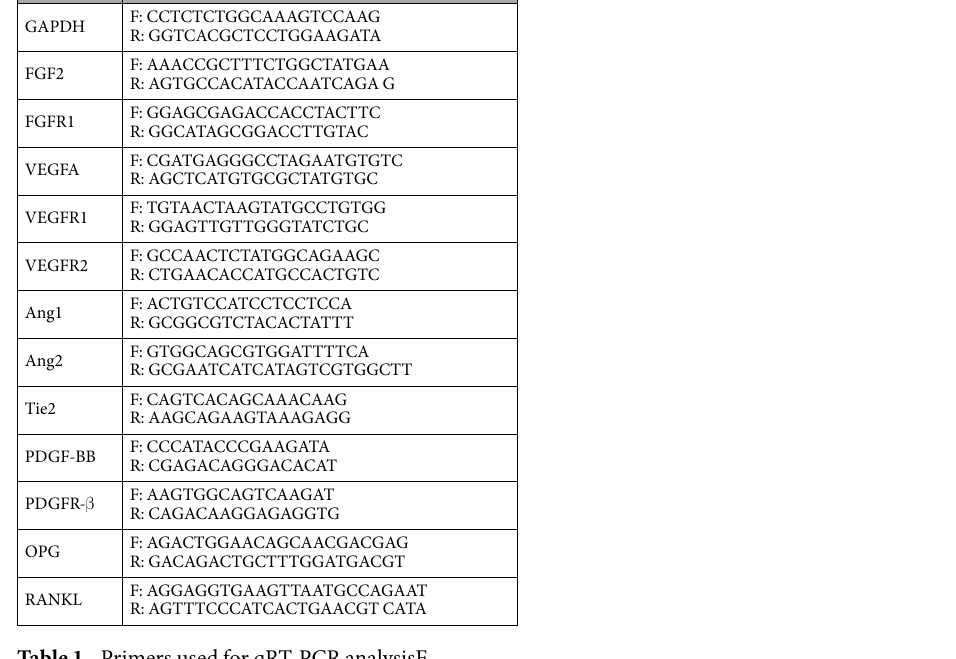
Table 1. Primers used for qRT-PCR